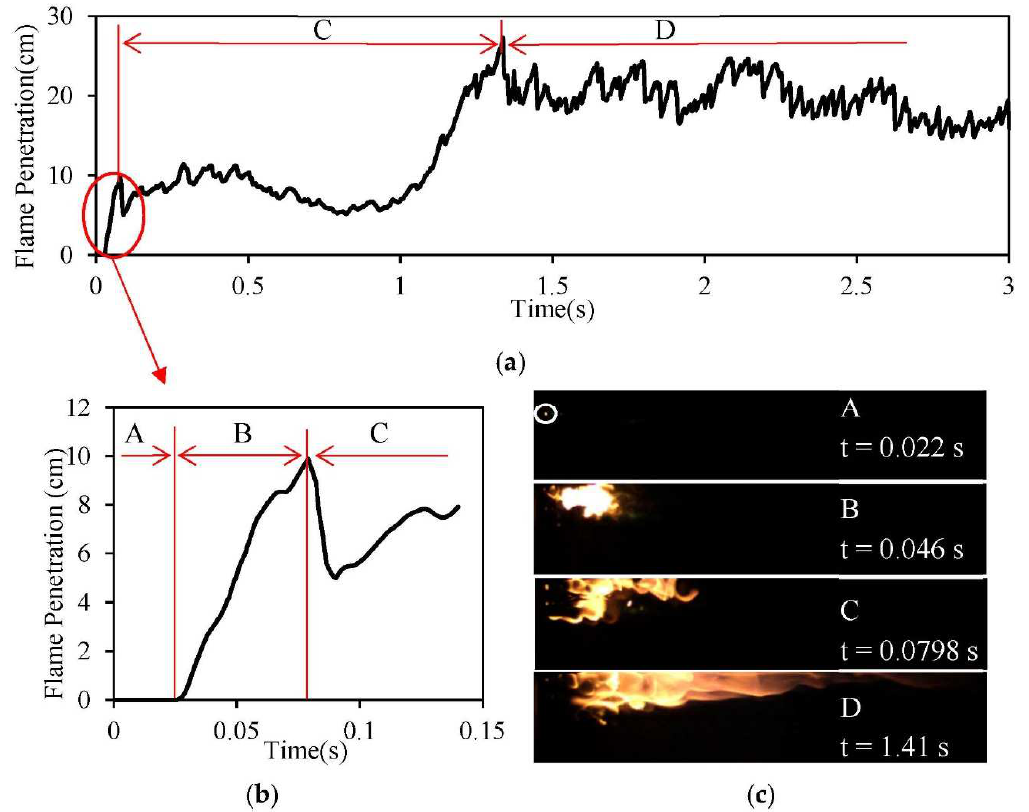
Figure 3. ( a ) Flame penetration, ( b ) local flame penetration magnification chart and ( c ) flame images with the air flow velocity of 1.4 m/s in the combustion chamber under the diesel flow rate of 10.0 mL/min.